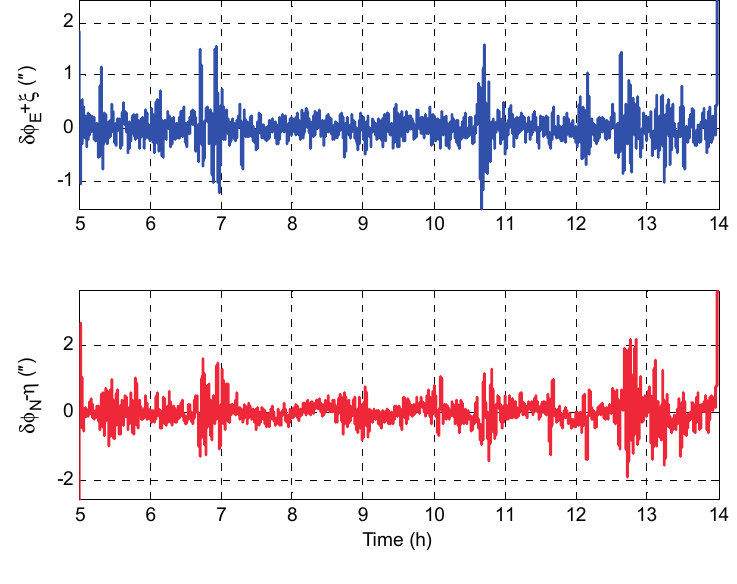
Figure 5. Geoid tracking error for INS/GNSS